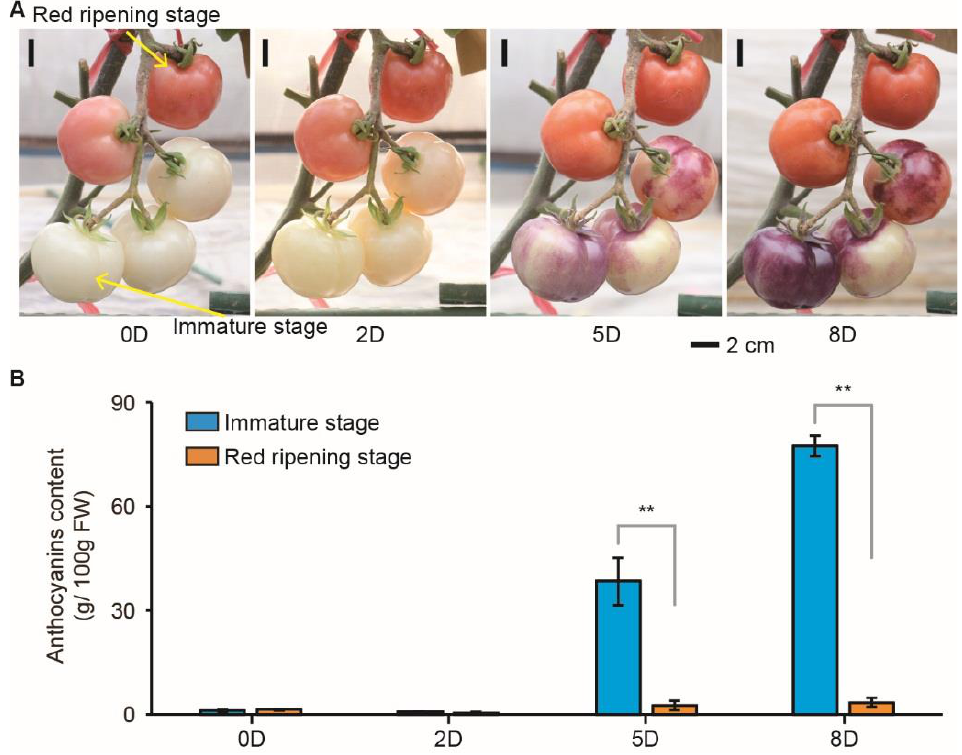
Figure 1. Fruit coloration and anthocyanin content analysis of immature and red ripening fruits of the purple tomato cultivar ‘Indigo Rose’ before and after removing bags. ( A ) The coloration of im- mature and red ripening fruits before (0D, 0 days) and after (2D, 5D, and 8D) removing bags. ( B ) Anthocyanin content in the fruit peel. Dates are presented as the mean ± SD of three biological rep- licates. The asterisks indicate significant differences, determined by the Student’s t -test (** p < 0.01); 0D, 2D, 5D, and 8D represent zero days before bag removal and 2, 5, and 8 days after removing bags.